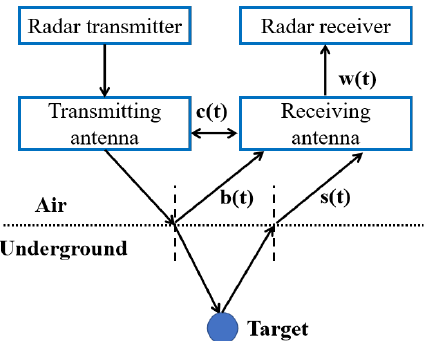
Figure 6. The schematic diagram of UAV − GPR system. A single radar echo is mainly composed of direct coupled wave between transmitter and receiver c ( t ), direct reflected wave from the ground